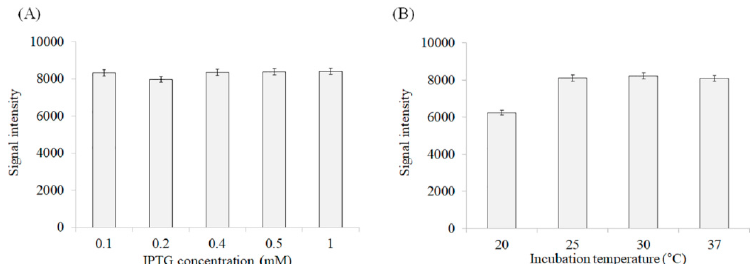
Figure 4. Expression efficiency of rD4BPL2 (Recombinant Bryopsis plumosa lectin 2, tetrameric construction) under different conditions. ( A ) Induction efficiency at different isopropyl β‐ D ‐ 1 ‐ thiogalactopyranoside (IPTG) concentrations (at 37 °C, OD600 = 0.6–0.8 for 3 h), ( B ) Effect of